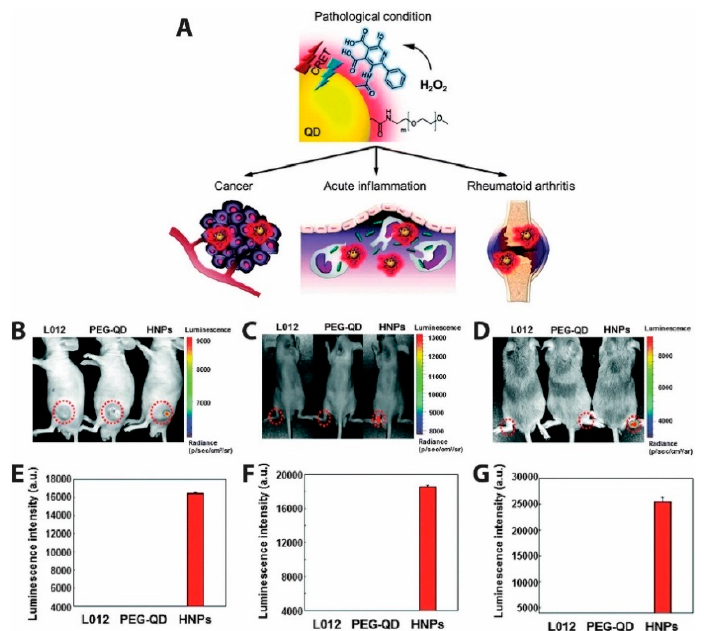
Figure 15. Hybrid nanoparticles (HNPs) with a conjugated luminol derivative (L012) produce NIR QD emission in response to reactive oxygen species in vivo. ( A ) Schematic representation of HNPs used for the detection of overproduced H 2 O 2 in various diseases states. CL signals generated by CRET in presence of hydrogen peroxide in mice bearing ( B ) tumor, ( C ) acute inflammation, and ( D ) arthritis. CL signal was emitted from the HNPs in all three disease models, each of which involves the overproduction of H 2 O 2 . CL was not observed form either L012 or QDs alone. ( E – G ) Quantification of the CRET signal intensities. Higher CRET signals were obtained from the late stage inflammation model ( D , G ) than the early stage inflammation model ( C , F ), suggesting higher and long lasting ROS in the arthritis model. Adapted with permission from [161]. Copyright 2016, The Royal Society of Chemistry.